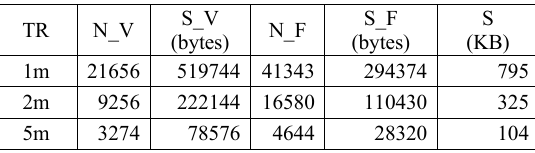
Table 2. Characteristics of the three sampled TIN. N_V: number of vertices; S_V: storage space for vertices;